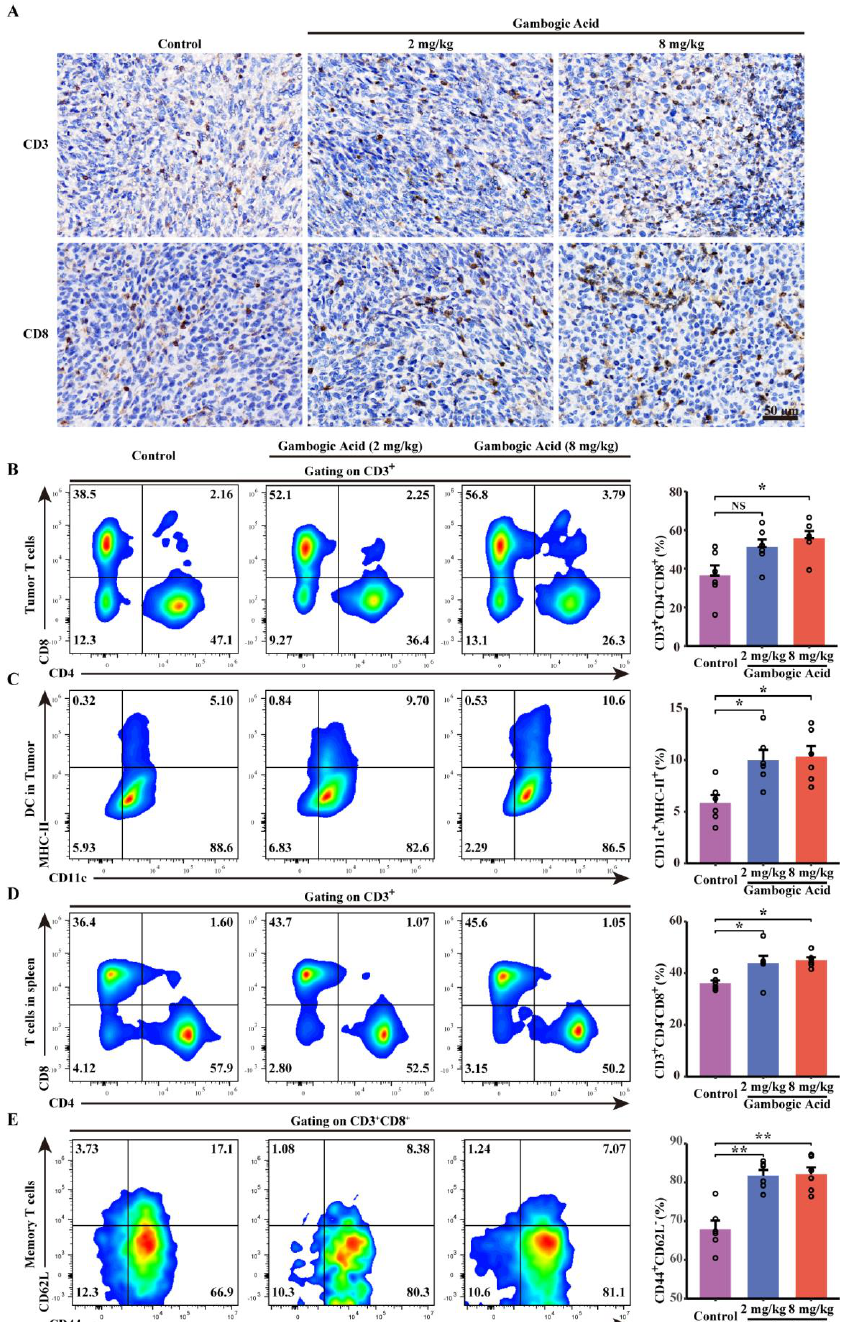
Figure 8. GA-induced pyroptosis regulates the tumor immune microenvironment. ( A ) CD3 and CD8 immunohistochemistry analysis of tumor tissues after GA treatments. ( B ) Representative flow cytometric analysis and quantitative analysis of proportions of CD8 + and CD4 + T cells gating on CD3 + cells within the tumor tissues. ( C ) Representative flow cytometric analysis and quantitative analysis the proportion of CD11c+MHC-II+ cells within the tumor tissues. ( D ) Representative flow cytometric analysis and quantitative analysis of the proportions of CD8 + and CD4 + T cells gating on CD3 + cells in the spleen. ( E ) Representative flow cytometric analysis and quantitative analysis the proportion of effector memory T cells (TEM) (CD44 + CD62L − ) gating on CD3 + CD8 + cells in the spleen. NS p > 0.05 vs. control, * p < 0.05 vs. control, ** p < 0.01 vs.